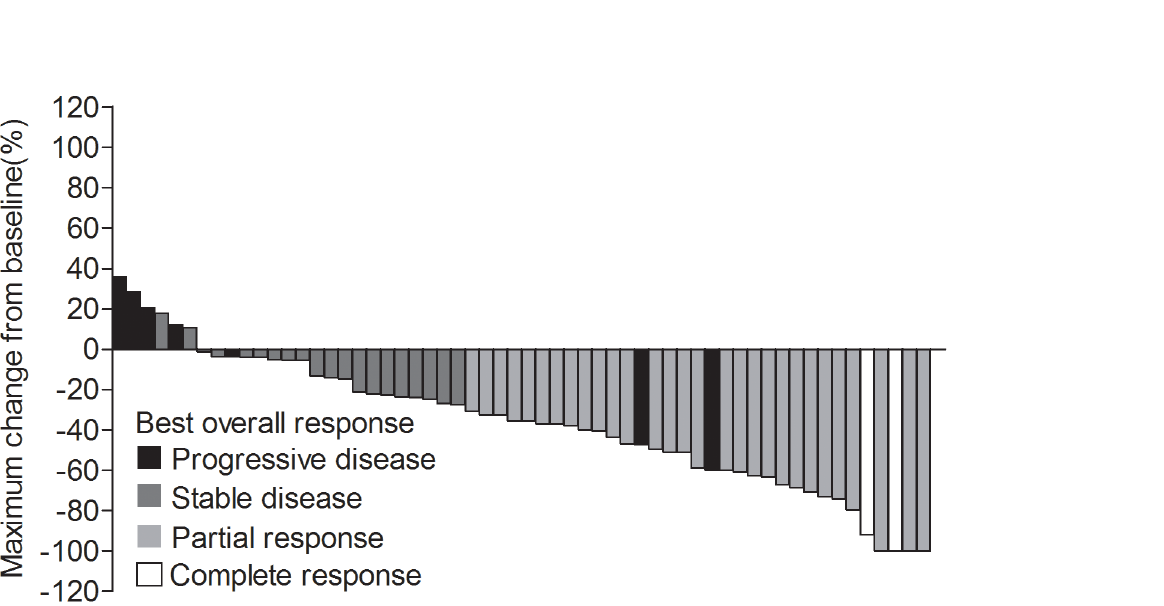
Fig 3. Waterfall plot of the maximum change in tumor size showed best overall responses in each patient.